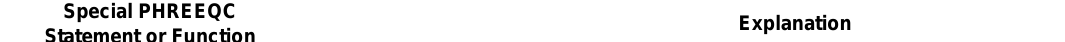
Table 8. Special Basic statements and functions for